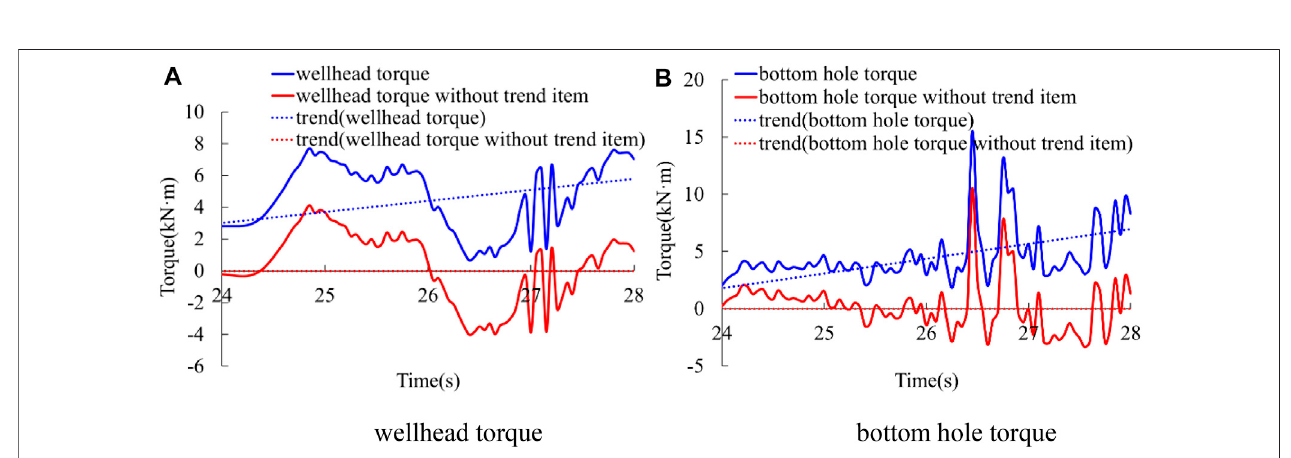
FIGURE 17 | Original signal and signal without trend item of wellhead torque and bottom hole torque.